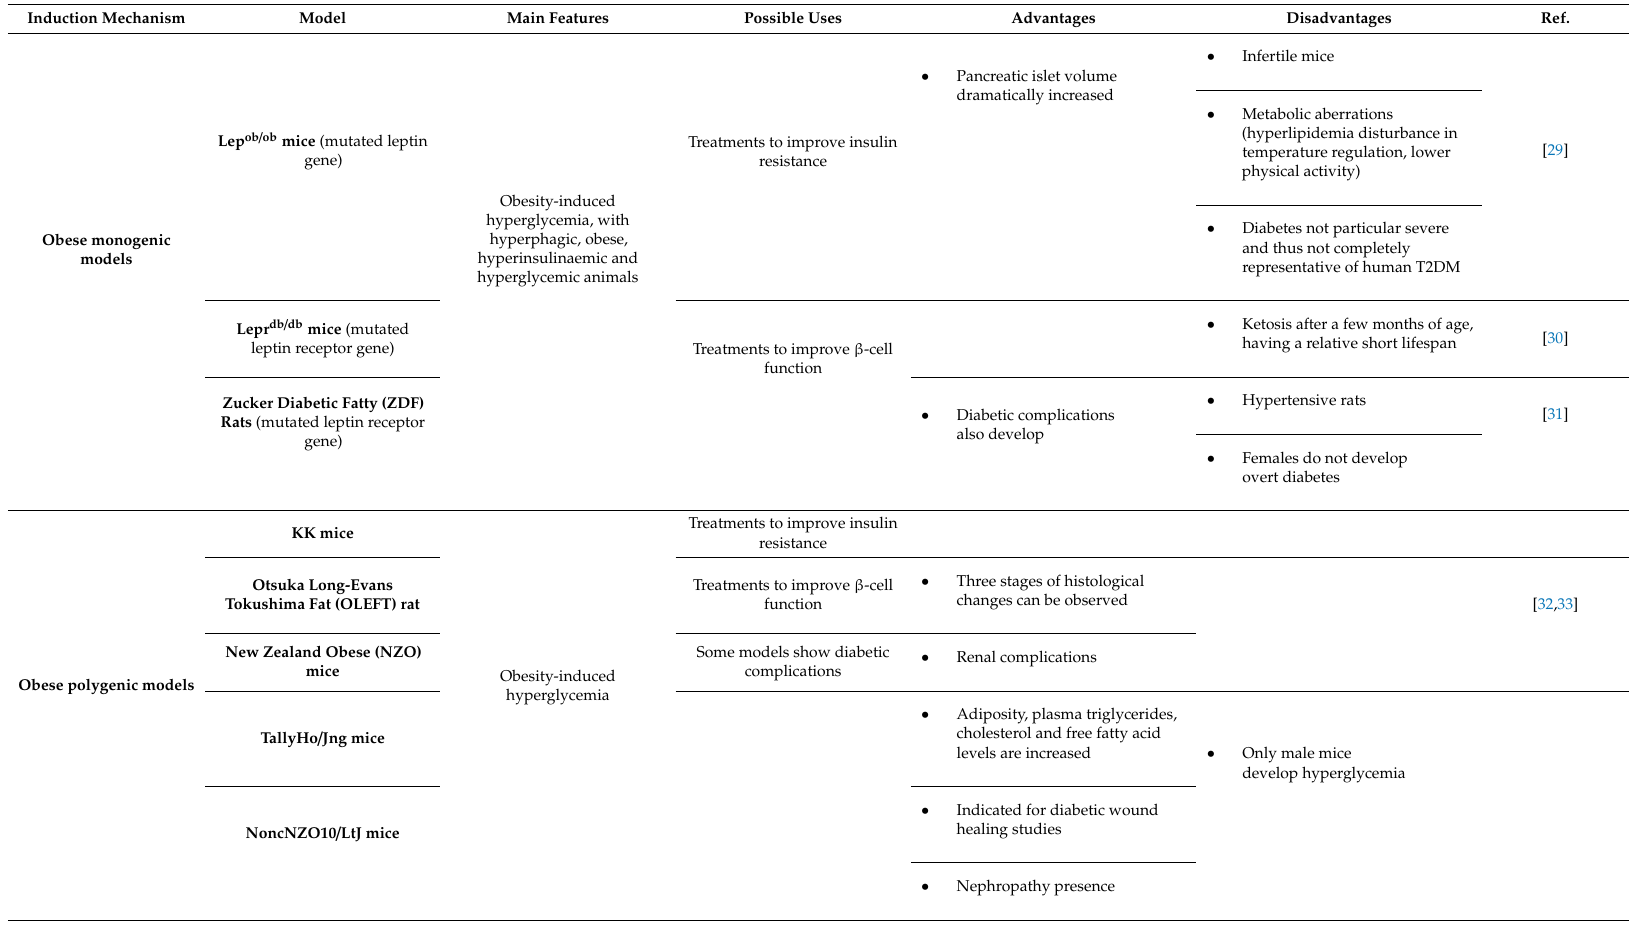
Table 2. Animal models most commonly used to study type 2 diabetes